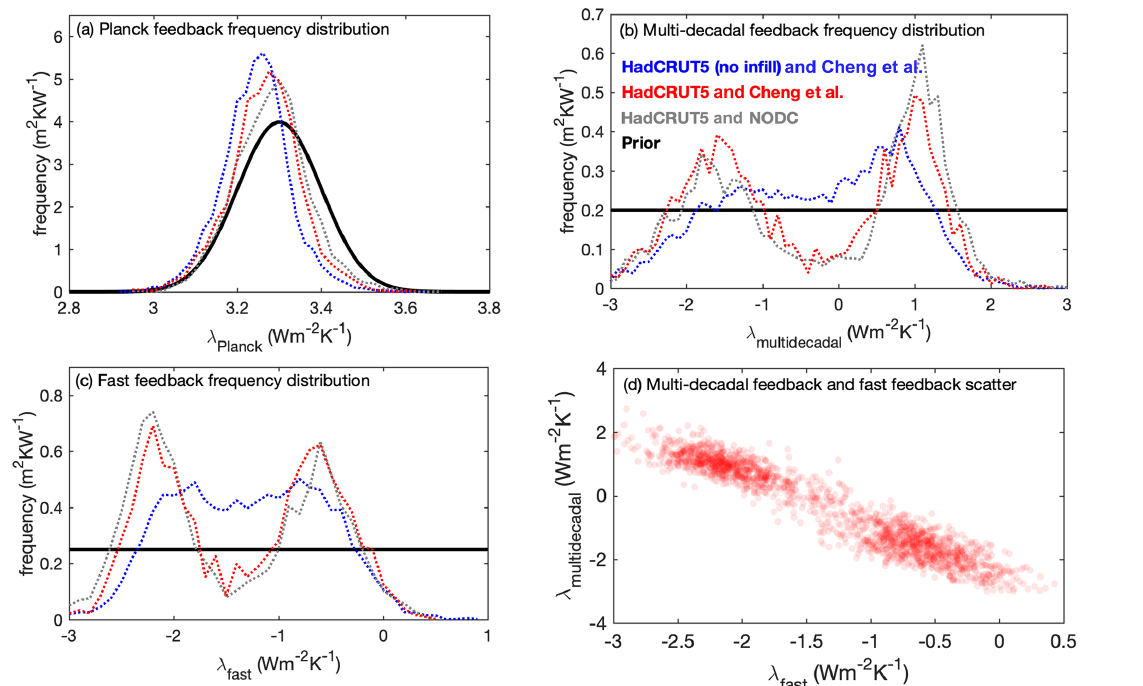
Figure 2. Prior and posterior probability densities for climate feedback terms: (a) the Planck climate feedback, (b) fast climate feedback, and (c) multi-decadal climate feedback. Shown are the prior distributions (thick black lines) and posterior distributions when constrained by different dataset combinations (dotted blue, red, and grey lines). Panel (d) shows a scatter plot of fast climate feedback and multi-decadal climate feedback values in the posterior ensemble constrained by the HadCRUT5 and Cheng et al. datasets.